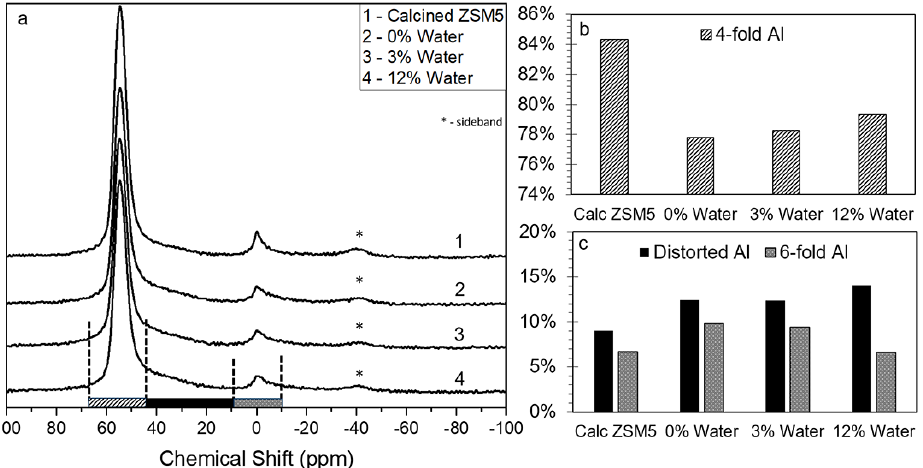
Figure 5. ( a ) 27 Al MAS NMR spectra of deactivated ZSM-5 zeolites; ( b ) deconvoluted integral of the peak at 60 ppm representing 4-fold coordinated aluminum sites; ( c ) deconvoluted integral of the peak at 0 ppm representing 6-fold coordinated aluminum sites and the deconvoluted integral of the intermittent region representing aluminum sites neither fully tetrahedrally nor octahedrally coordinated. * denotes a sideband echo of the 60 ppm peak generated by the